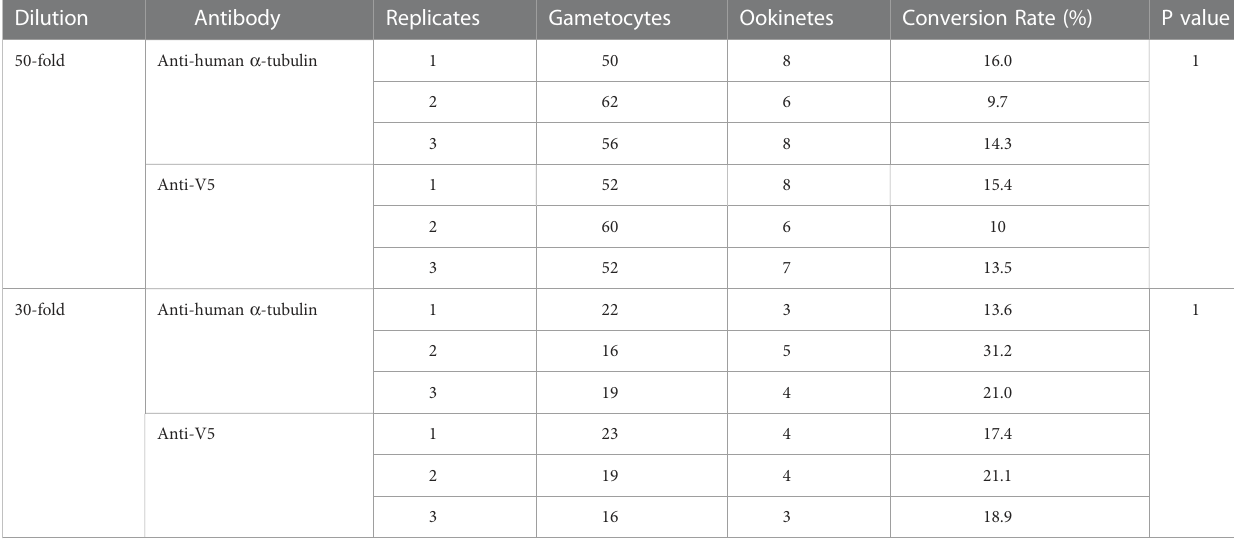
TABLE 1 The effects of antibodies on ookinete